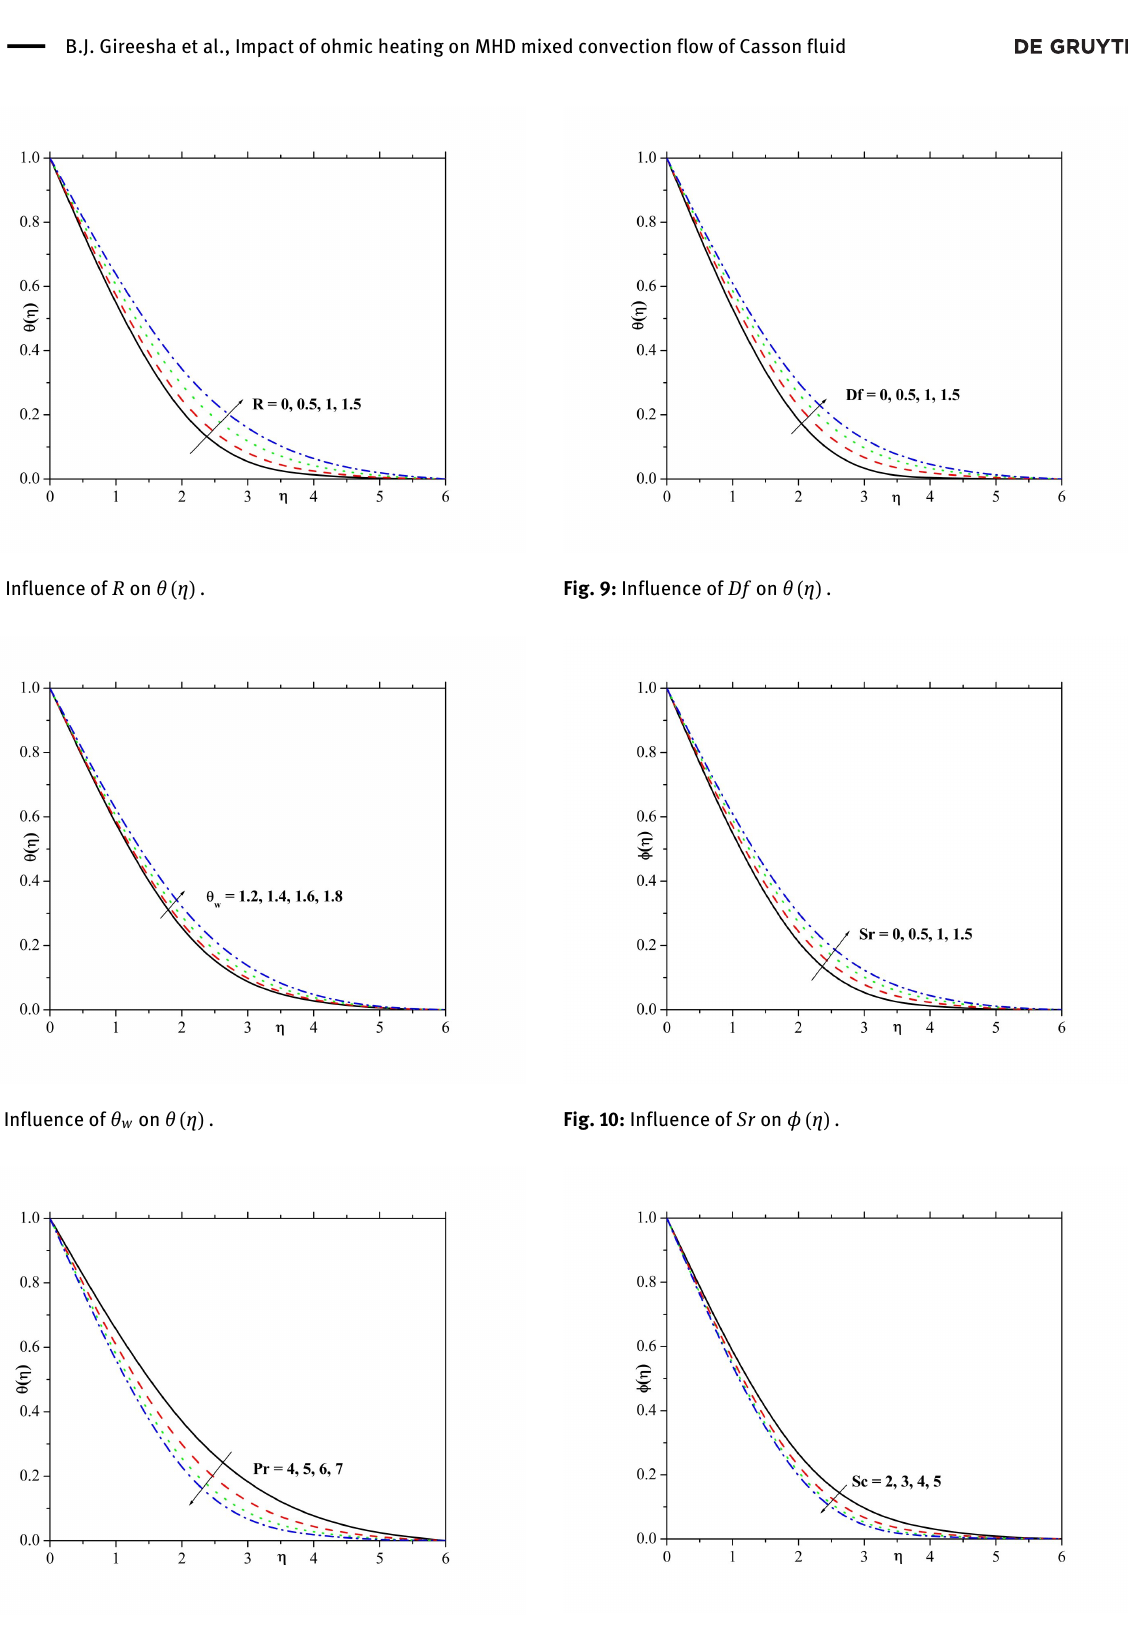
Fig. 11: Influence of Sc on ϕ ( η )